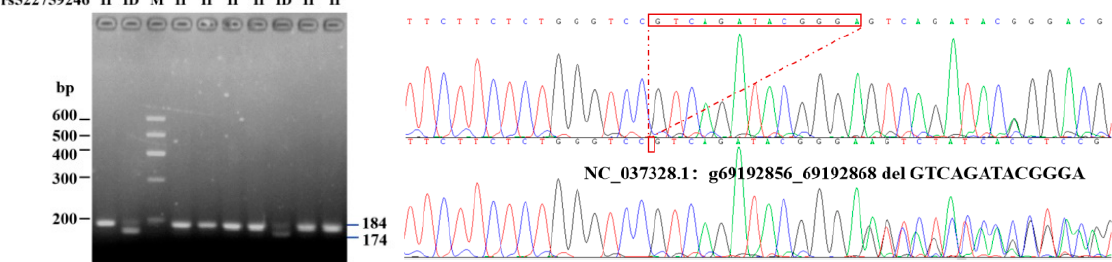
Figure 1. Electrophoretogram and sequence diagram of P1-D 13-bp of ITG β 5 gene.